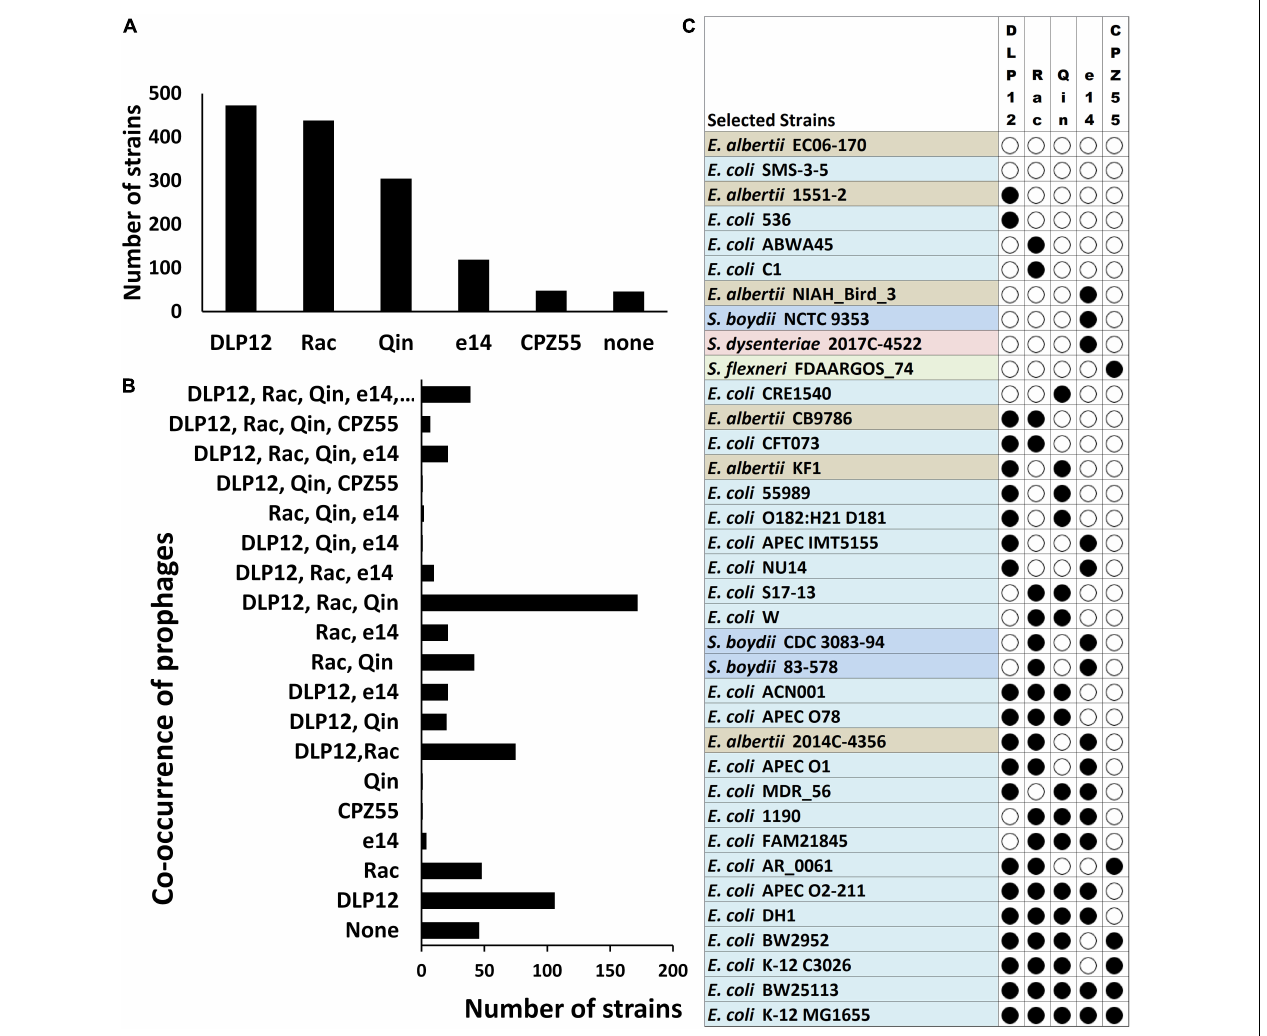
FIGURE 5 | Locus-specific distribution of the five prophages (with reference to E. coli MG1655 strain) in 638 completely sequenced E. coli strains. The cryptic prophages (DLP12, e14, Rac, CPZ-55, and Qin) of MG1655 strain were analyzed for their distribution within 638 completely sequenced E. coli strains taking the bacterial and prophage borders sequences as a query in BLASTn. Only cryptic prophages of MG1655 strain with location specificity were analyzed. Other strains may have various other prophages at multiple locations. (A) The prevalence of each cryptic prophage within various Escherichia and Shigella strains. The distribution was determined by curating the BLAST hits obtained in completely sequenced strains showing > 85% sequence identity. (B) The prevalence of various permutations of prophage co-occurrence within various Escherichia and Shigella strains. (C) The diversity in the locus-specific prophage distribution across Escherichia and Shigella species. Only representative strains are indicated for illustration